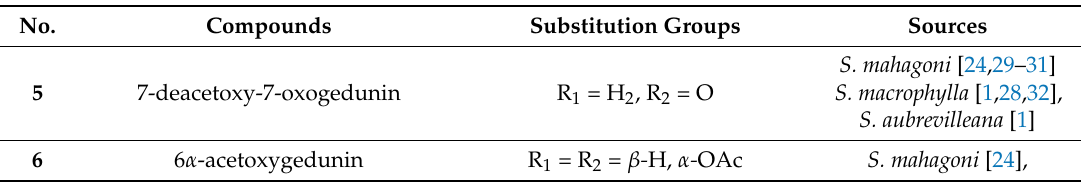
Figure 2. Chemical structures of gedunin ‐ type limonoids 5 – 13 . Table 1. Structures and sources of gedunin ‐ type limonoids 5 – 13 .